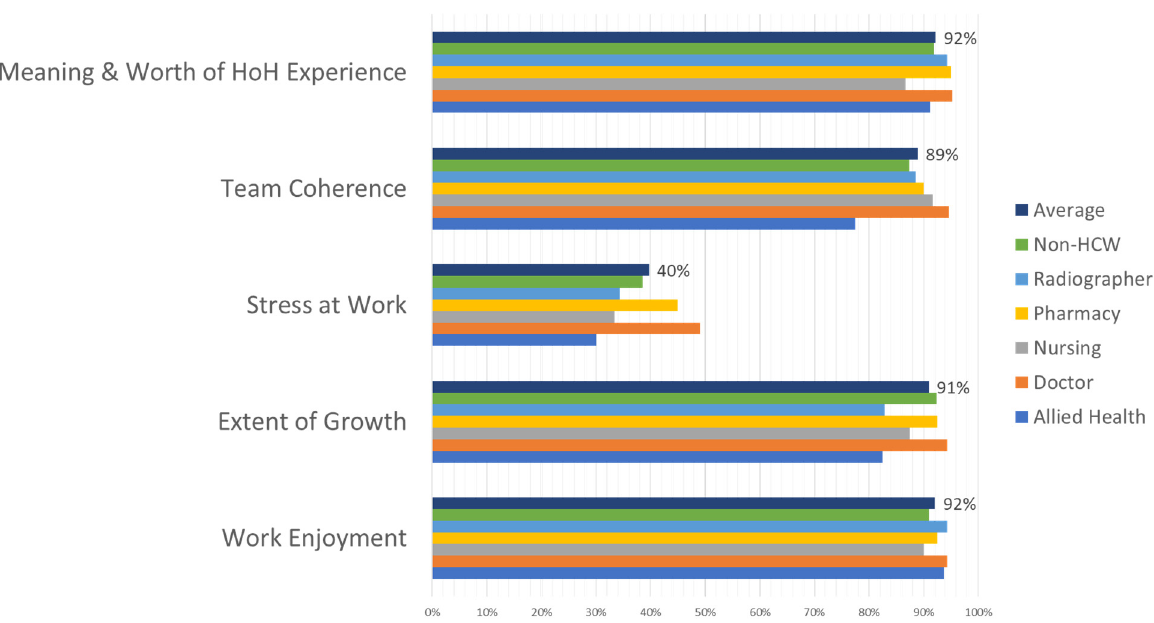
Figure 4. Personal growth score per sta ff category.